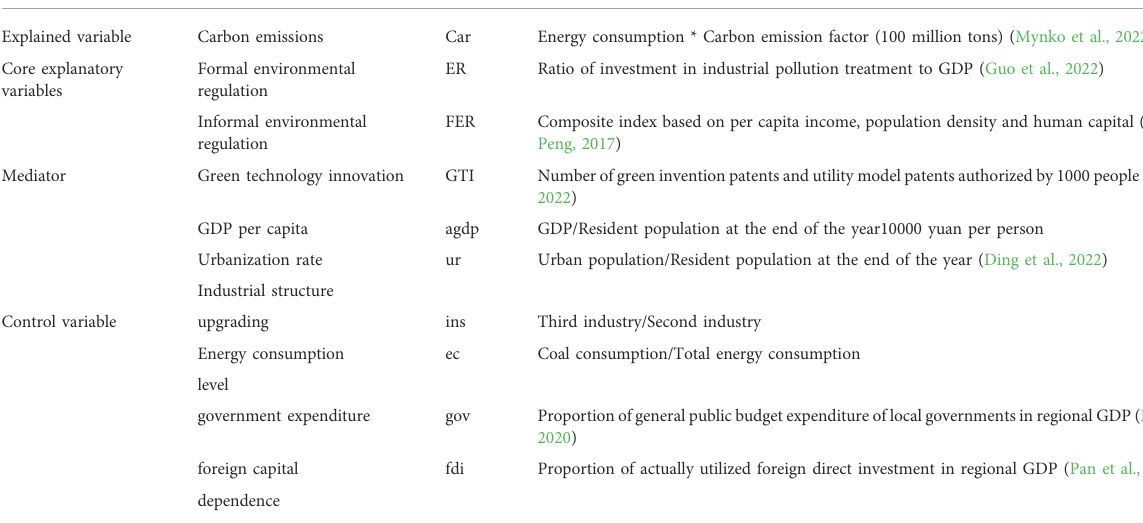
TABLE 1 Selection and measuring methods of variables.